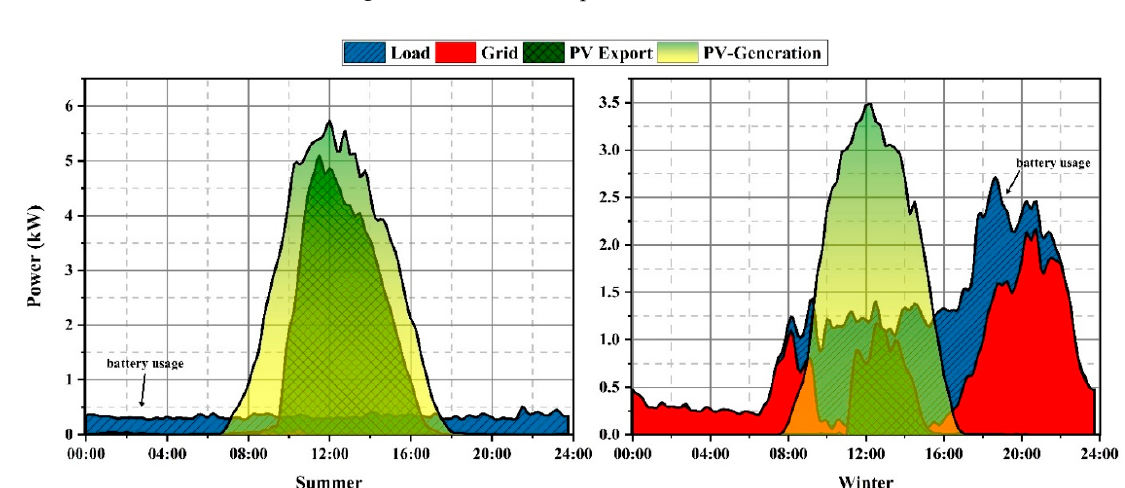
Figure 5. Seasonal load profile for Gen Y.